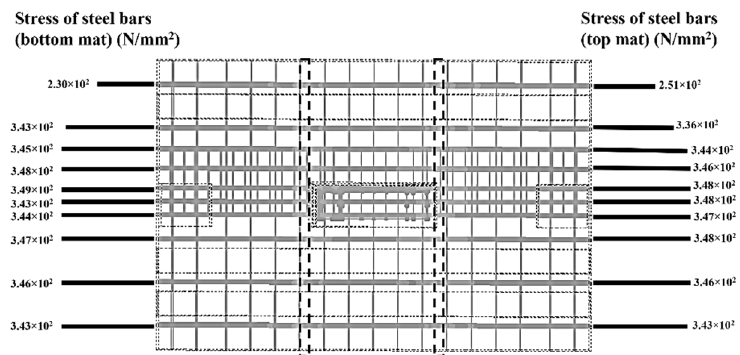
Figure 18. Comparison of lateral force ~ lateral drift ratio (%) for Model 1.